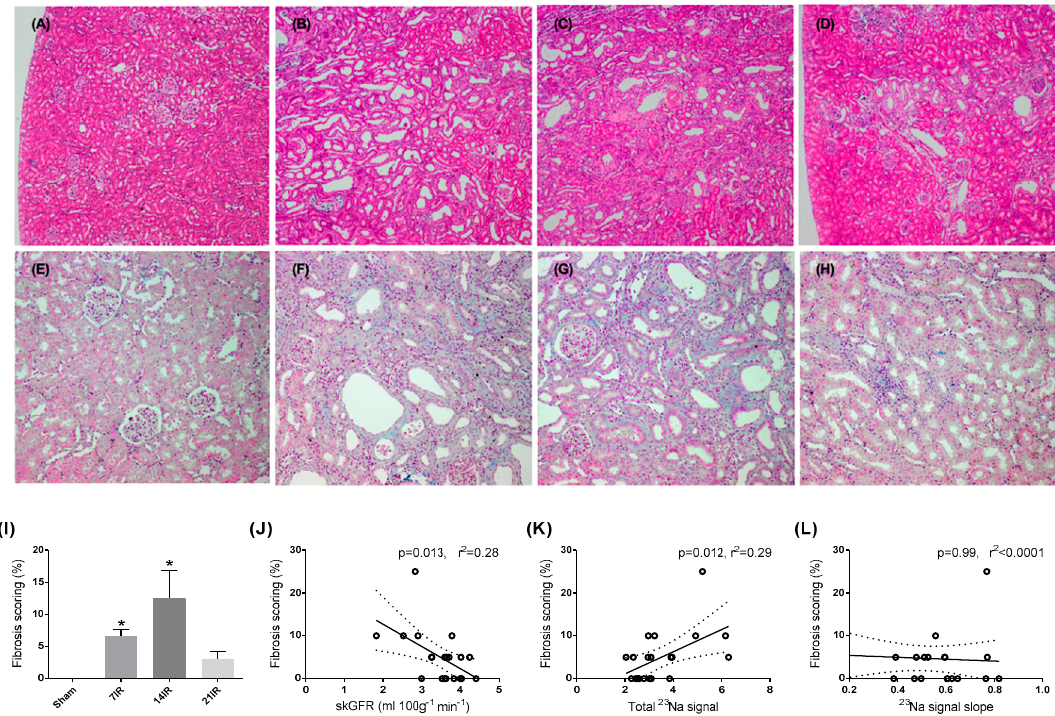
Figure 5. Fibrosis scoring of renal tissue after bilateral ischemia reperfusion injury (IR) and its